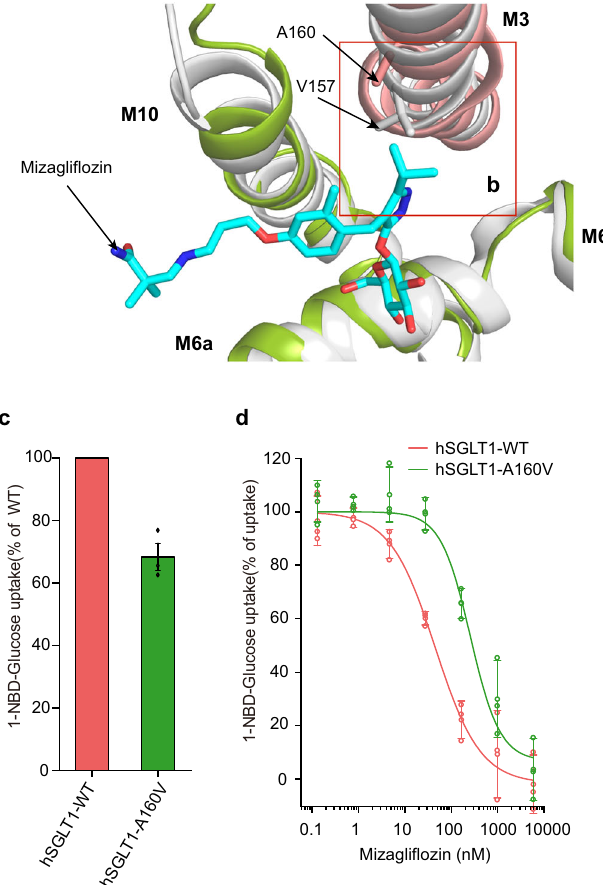
indicatedbydashes. c The1-NBD-glucoseuptakeactivitiesofwild-typehSGLT1and A160Vmutant. d Theinhibitionofwild-typehSGLT1anditsmutantbymizagli fl ozin in the 1-NBD-glucose uptake assay. e The 1-NBD-glucose uptake activities of wild- typehSGLT2andV157Amutant. f Theinhibitionofwild-typehSGLT2anditsmutant by mizagli fl ozin in the 1-NBD-glucose uptake assay. (Data are shown as means± standarddeviations; n = 3biologicallyindependent experiments).Source data are provided as a Source Data fi